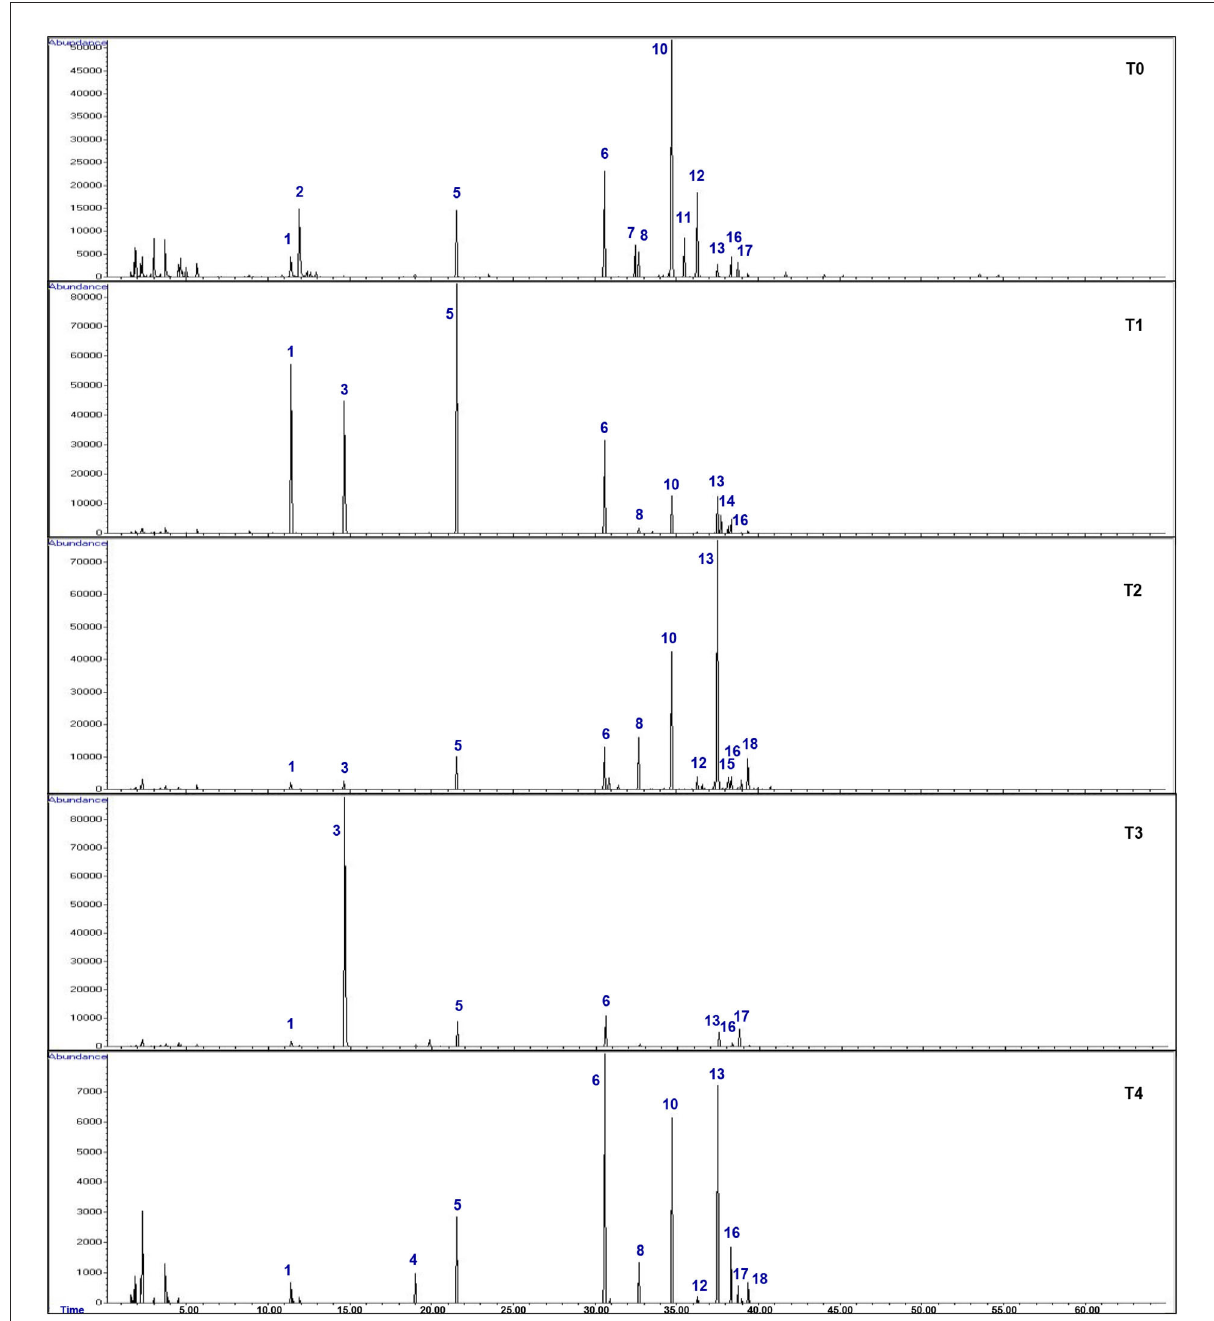
which are responsible for drought stress